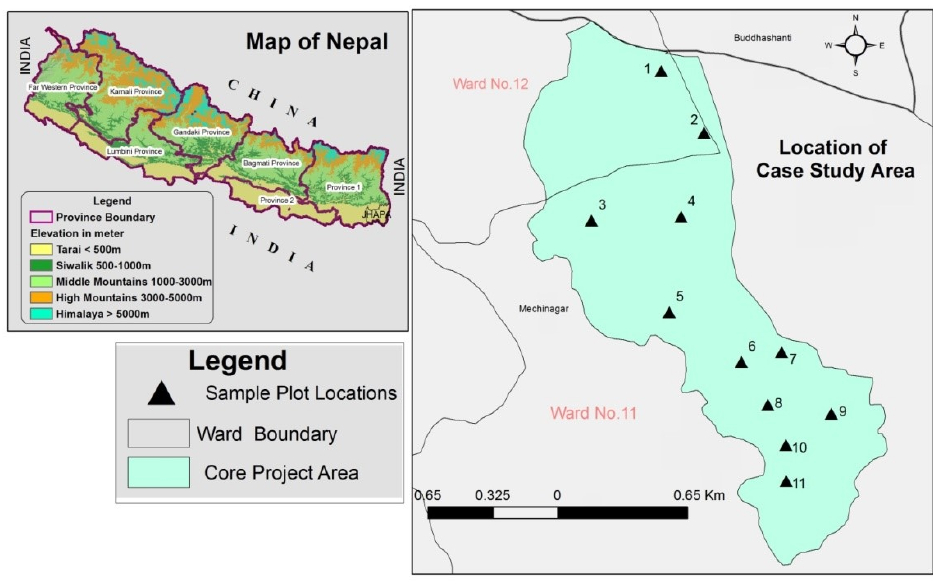
Figure 2. Location map of the case study area.